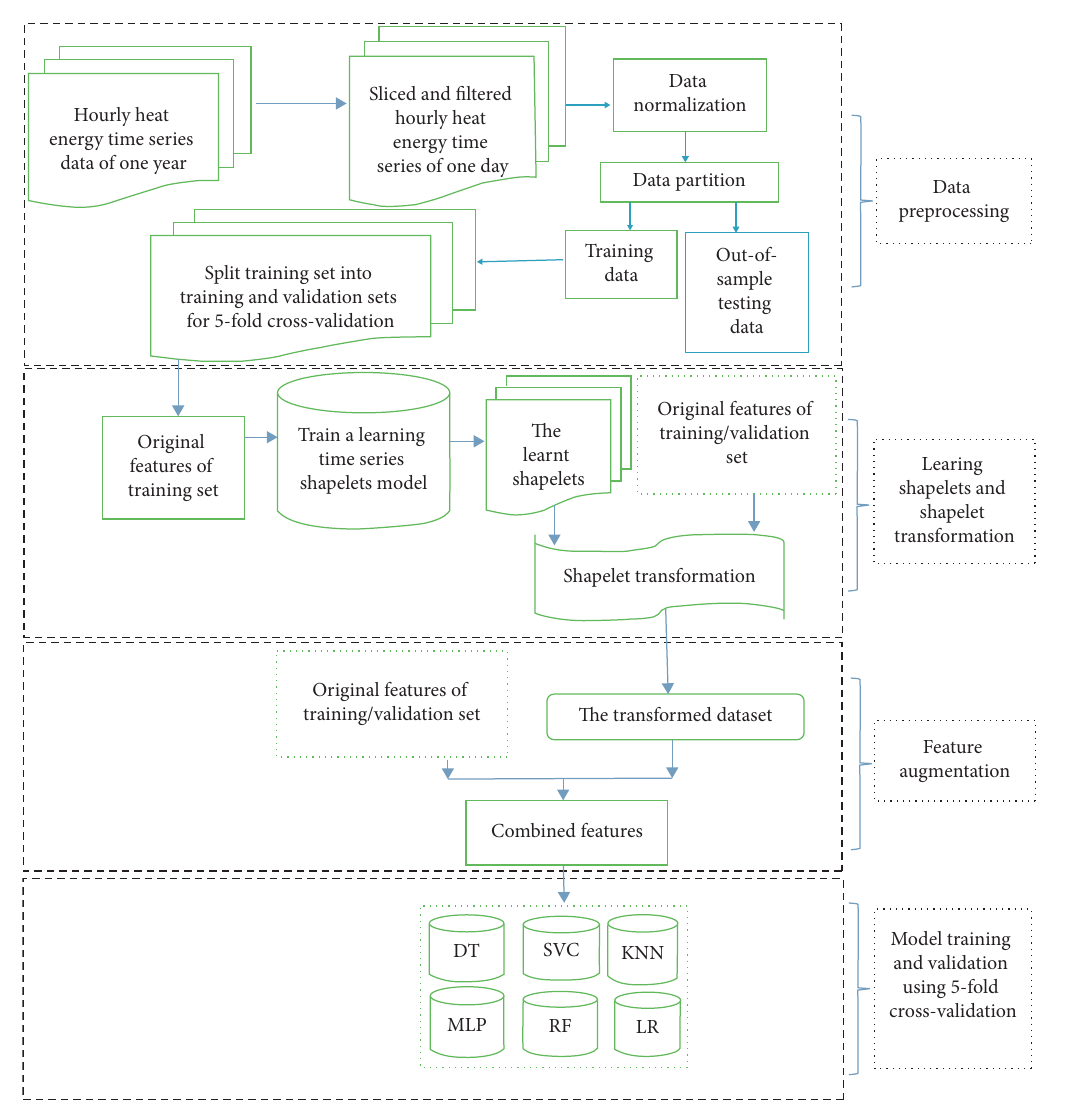
Figure 1: The workflow of the proposed approach for training and